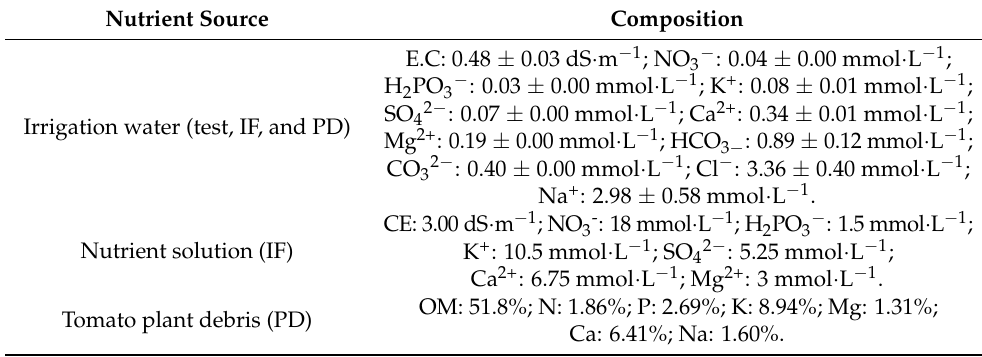
Table 1. Nutrient sources used in the different experimental plots. Nutrient Source